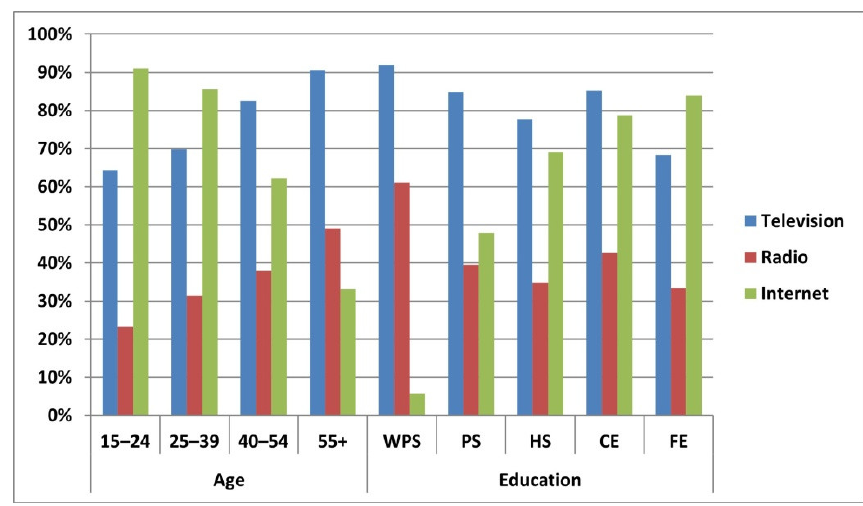
Figure 11. Age and education impact on main sources of general information.